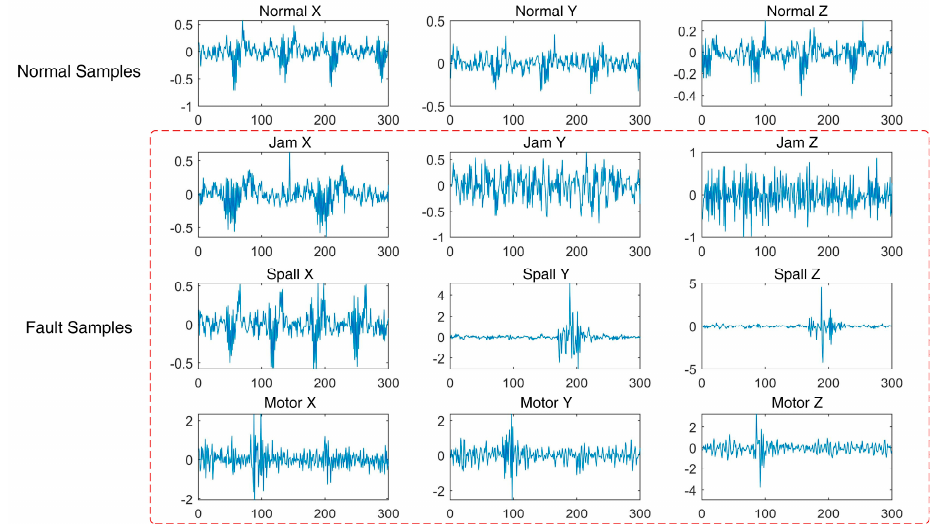
Figure 5. Acceleration signal. Jam is the ball screw return channel jam. Spall means screw surface spall. Motor denotes the motor failure.